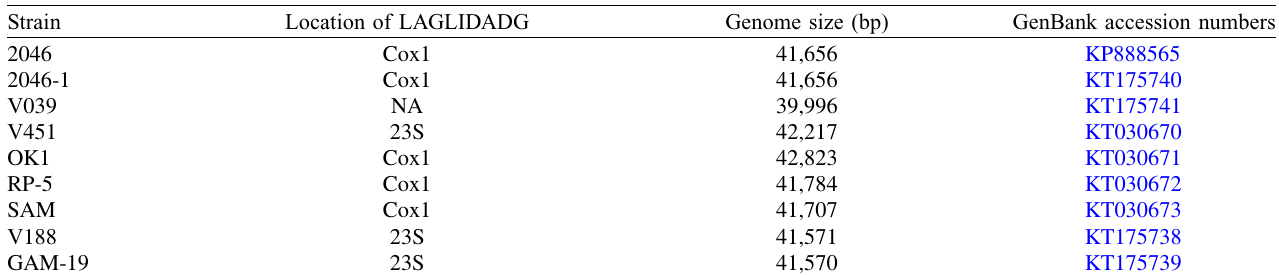
Table 4. B. mandrillaris mitochondrial genomes. Information from Greninger et al. [28], all the mtDNA was sequenced with the Illumina – MiSeq